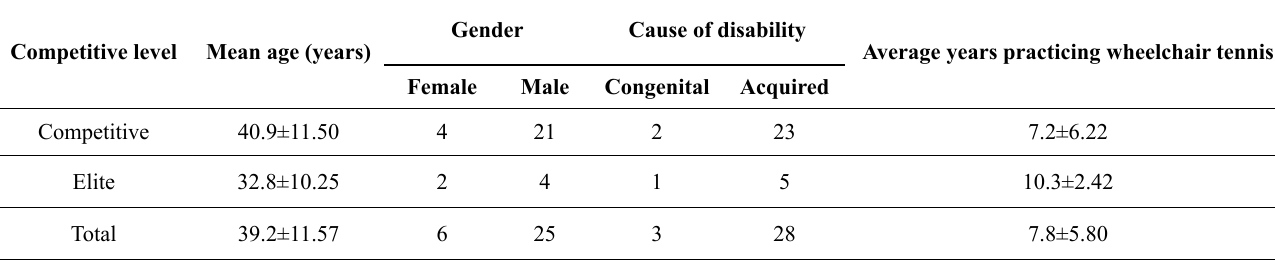
Table 1. Personal characteristics of Wheelchair tennis